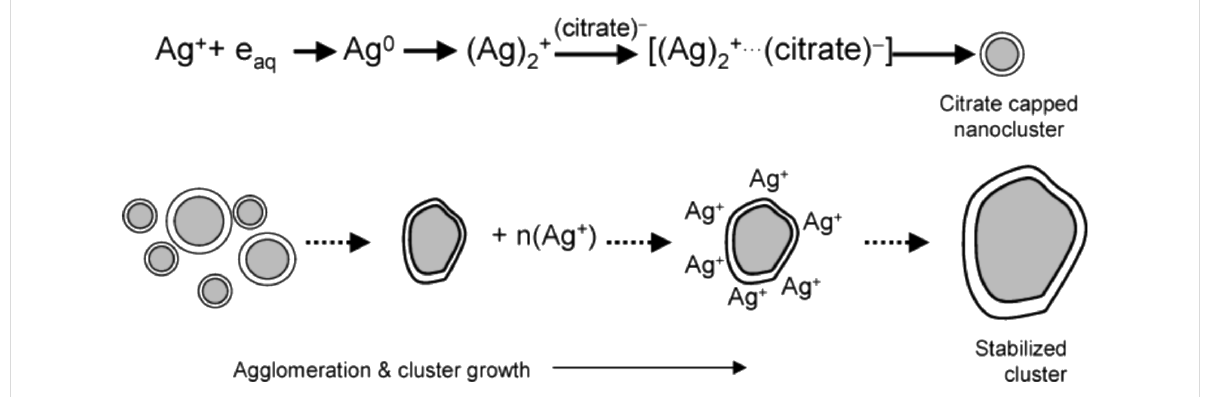
Figure 8: Primary and secondary growth steps in the formation of AgNPs through the citrate ion reduction technique. Reprinted with permission from [137], Copyright 2004 American Chemical Society.